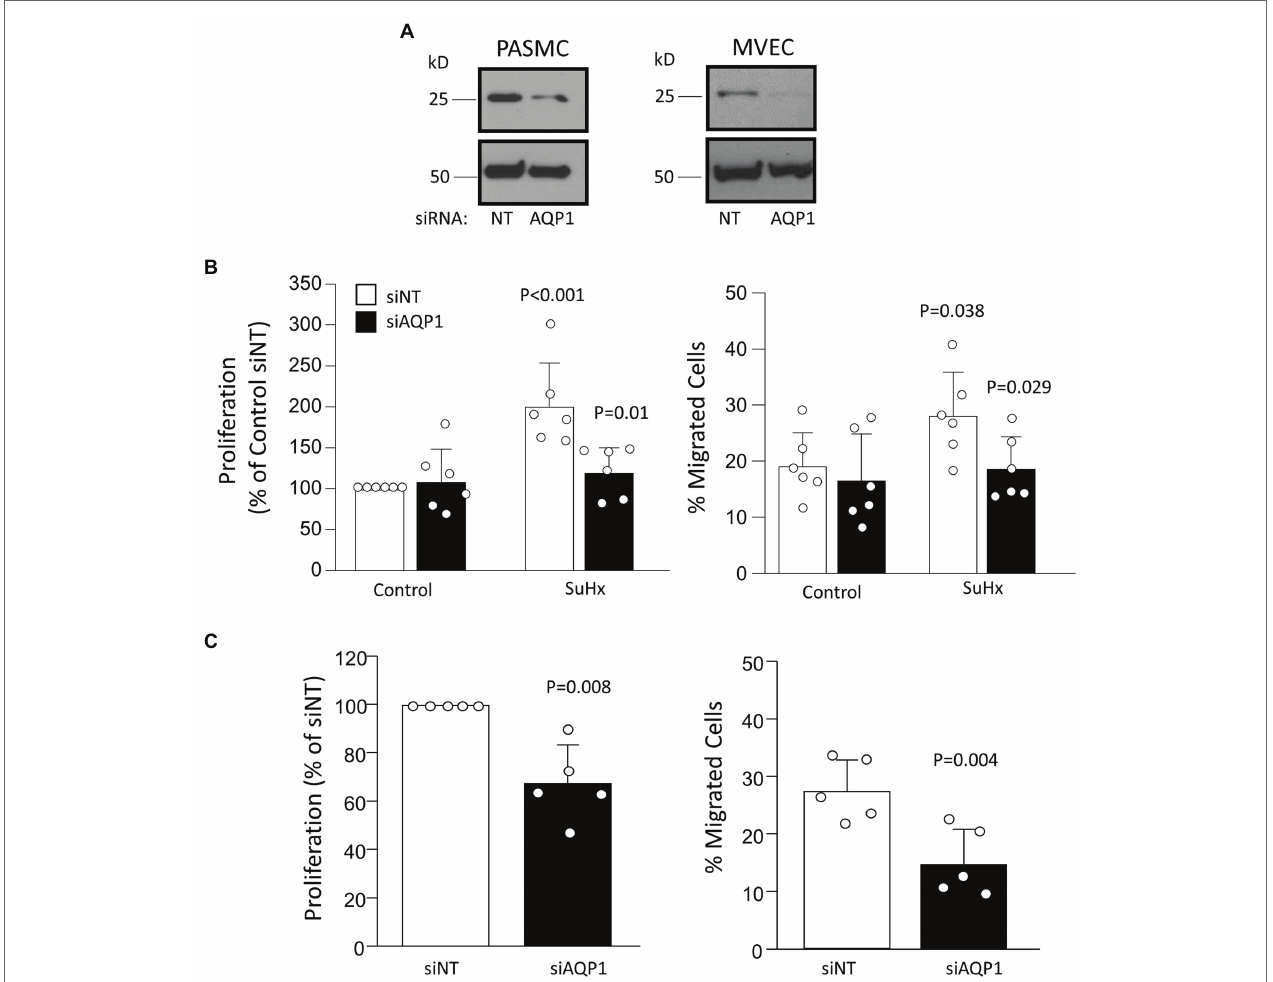
FIGURE 5 | Effect of depleting AQP1 on proliferation and migration. (A) Representative images demonstrating level of protein knockdown achieved using siRNA directed against AQP1 (siAQP1) compared to non-targeting siRNA (siNT). Result representative of at least five experiments for each cell type performed on cells from different animals. (B) Bar graphs (mean ± SD values) for proliferation, measured by BrdU incorporation and normalized to control, and migration, measured via transwell assay, in PASMCs isolated from control and SuHx rats. Values of p for proliferation and migration in PASMCs were determined from two-way ANOVA with Holm-Sidak post test to determine differences between specific groups. (C) Bar graphs (mean ± SD values) for proliferation and migrated cells in MVEC from SuHx rats. Values of p determined by t -test (migration) or one-sample t -test (proliferation) against a mean of 100. For all graphs, each dot represents samples from different